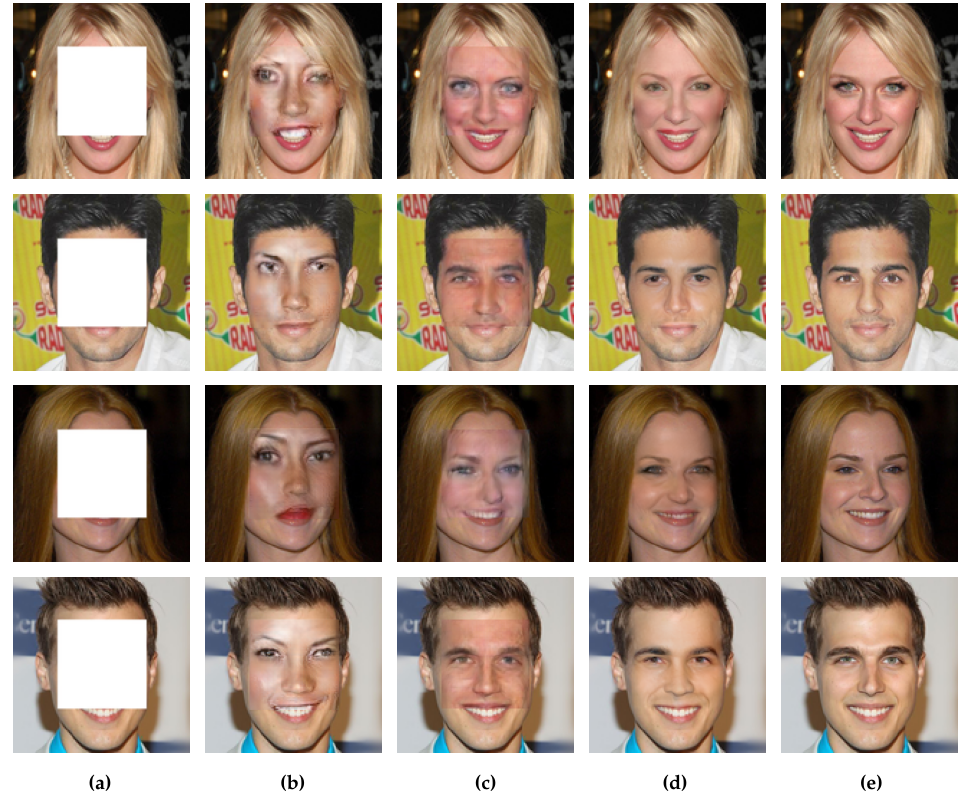
Figure 7. Completion results on the center rectangle mask. ( a ) Masked images. ( b ) GLCIC results [8]. ( c ) CE results [5]. ( d ) Our results. ( e ) Original